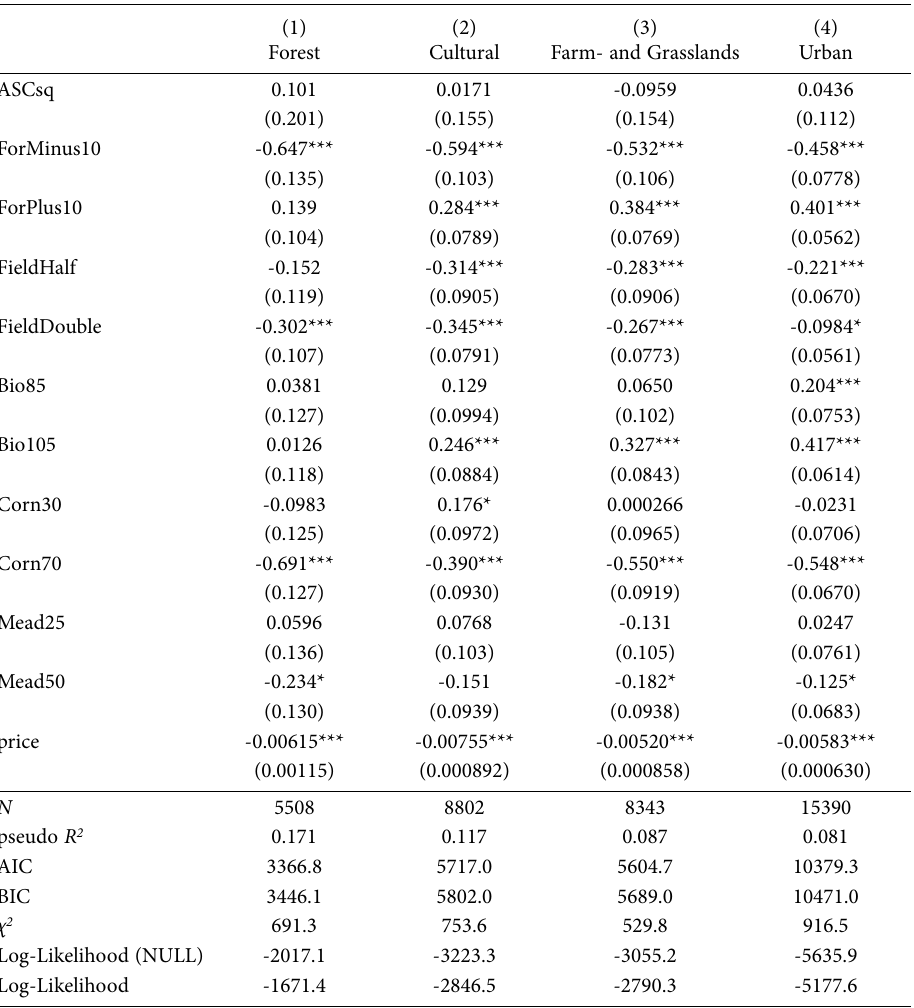
Table 8. Conditional logit models by